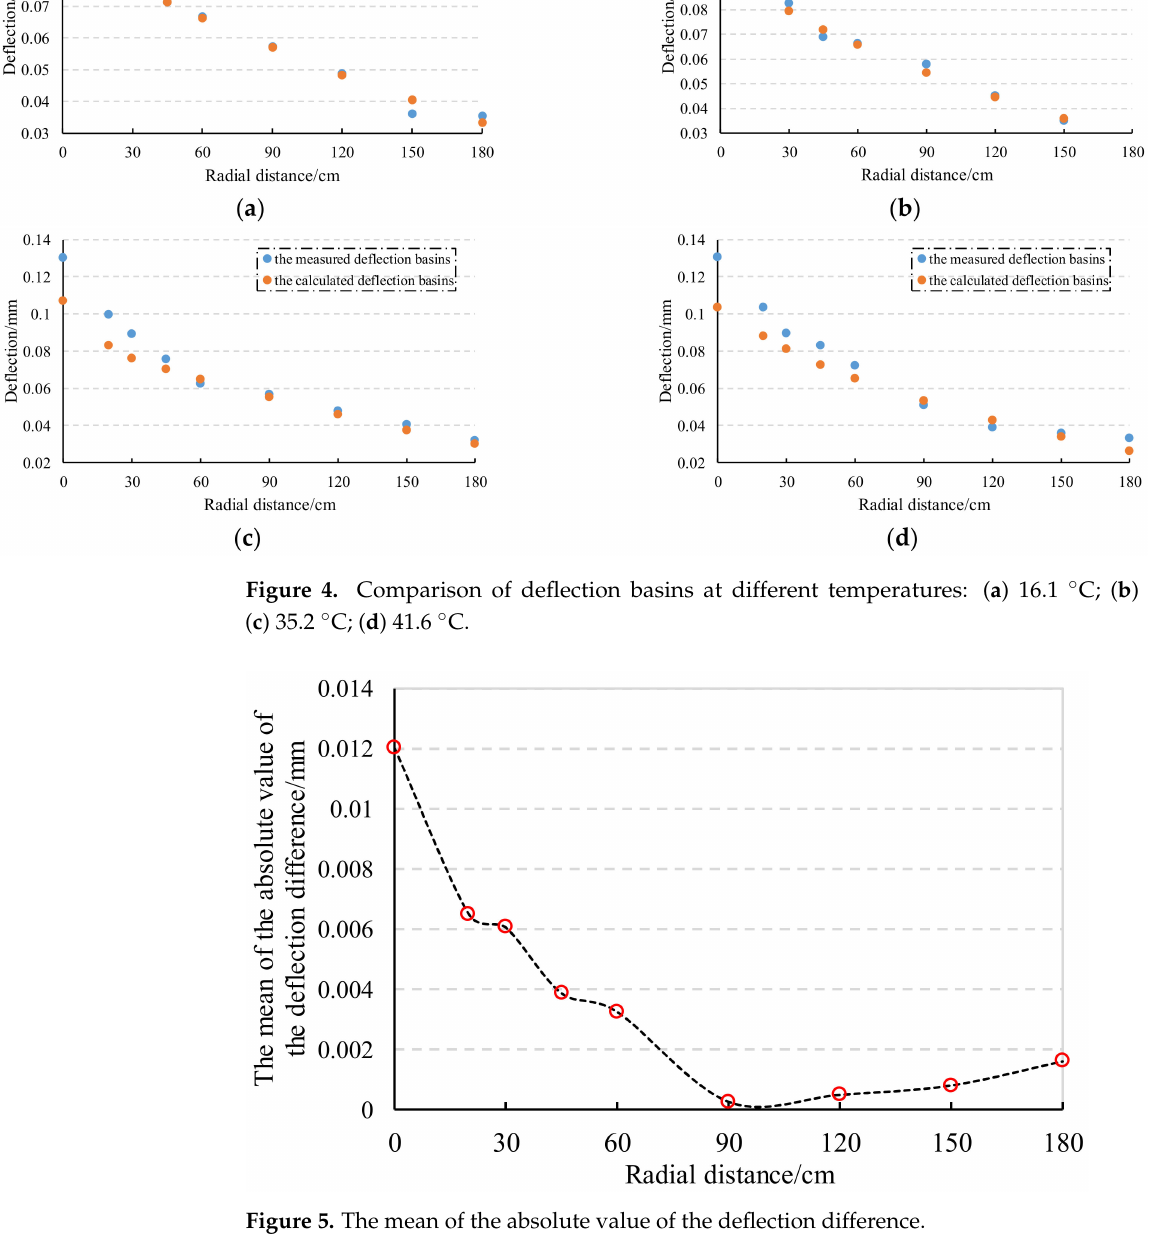
Figure 5. The mean of the absolute value of the deflection